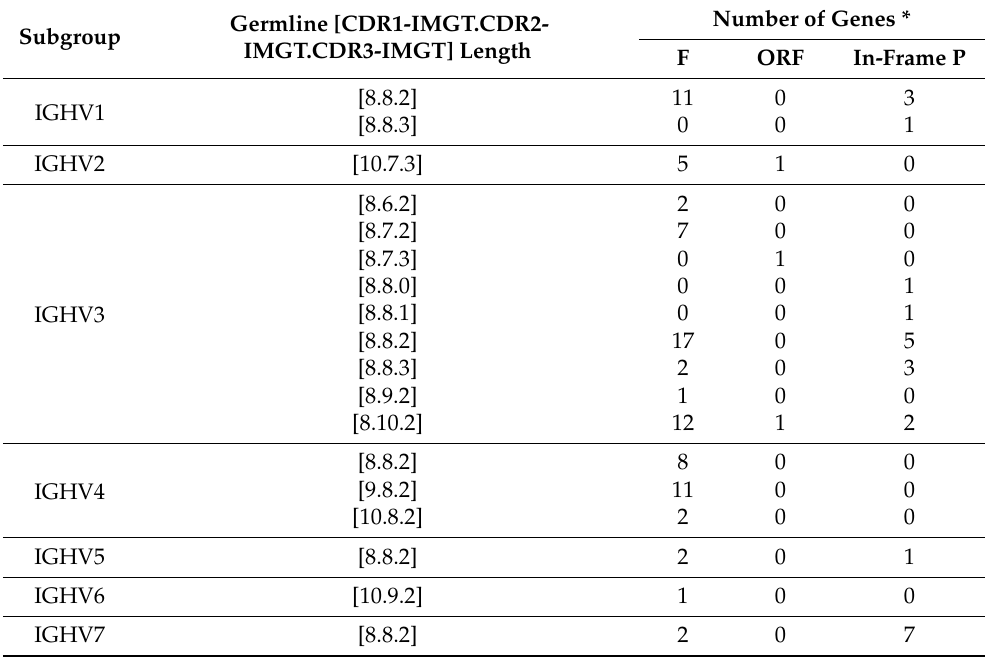
Table 7. CDR-IMGT lengths distribution in each IGHV subgroup.